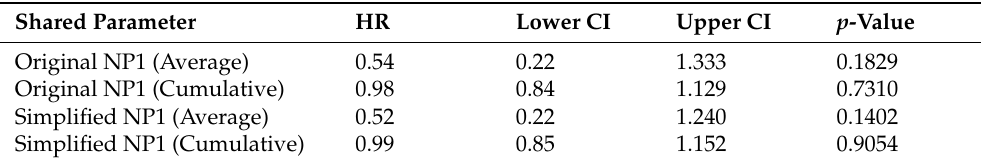
Table 5. Longitudinal association of NP1 with T1D, adjusted for HLA, race/ethnicity, sex and family history of